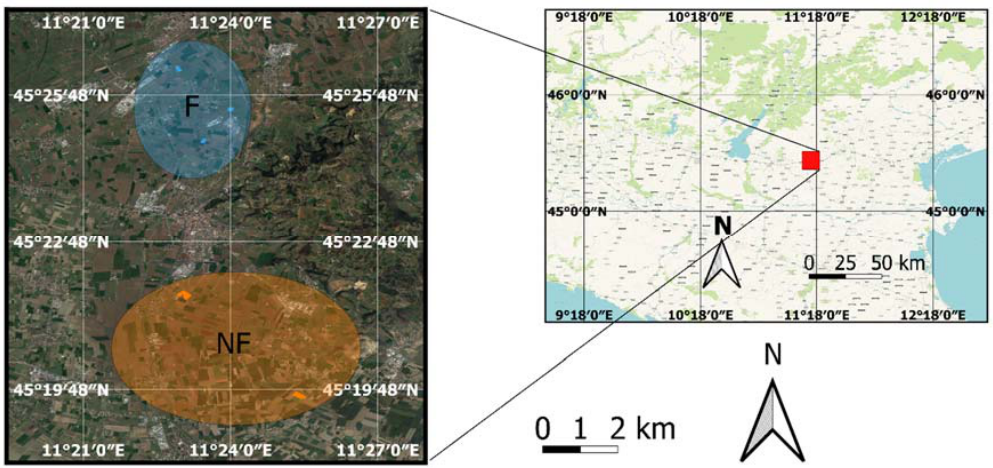
Figure 2. The study area is in Veneto Region, province of Vicenza. The north–south distance of frost ‐ affected vineyards (F) and control area (NF) is approx. 10 km.